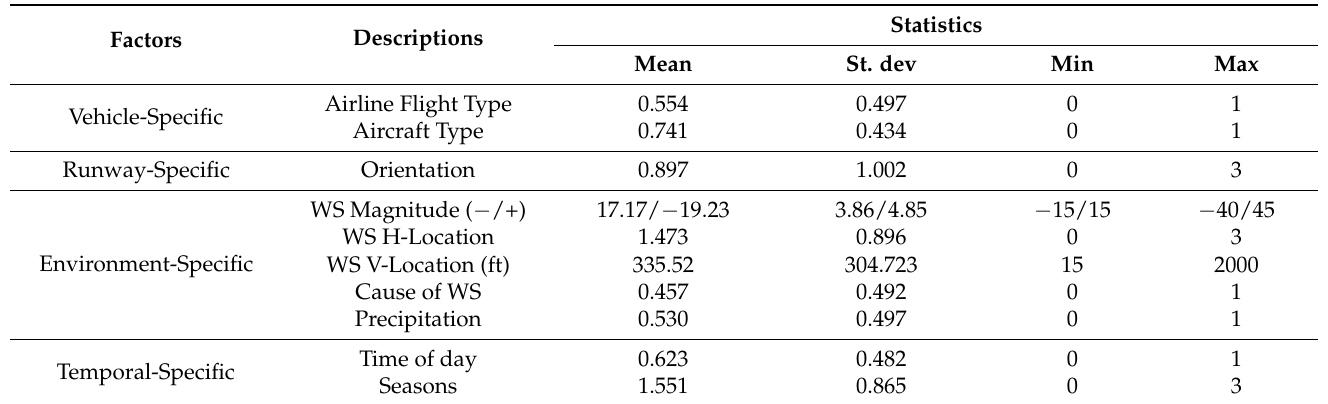
Table 5. Descriptive statistics of various environmental and situational factors.